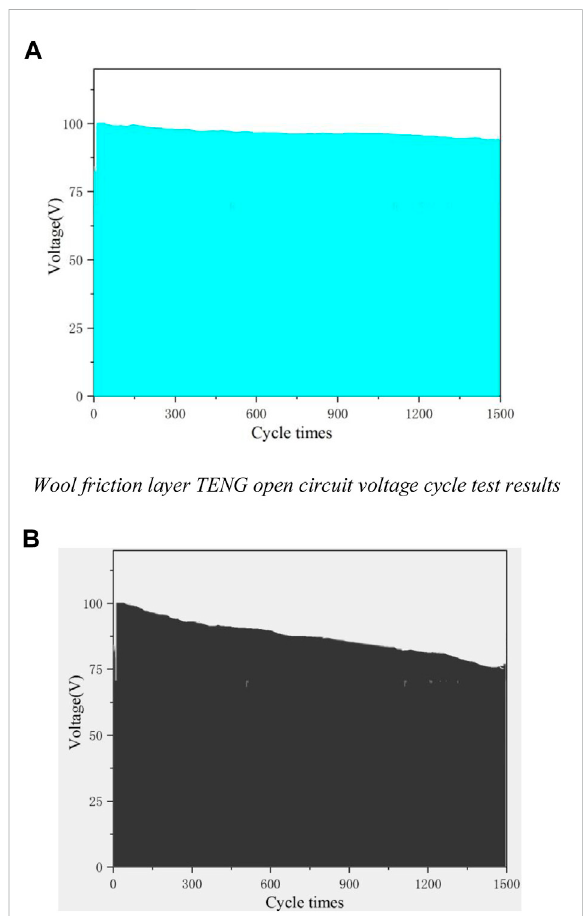
FIGURE 11 TENG durability test results. (A) Wool friction layer TENG open circuit voltage cycle test results. (B) TENG open circuit voltage test results for aluminium foil friction